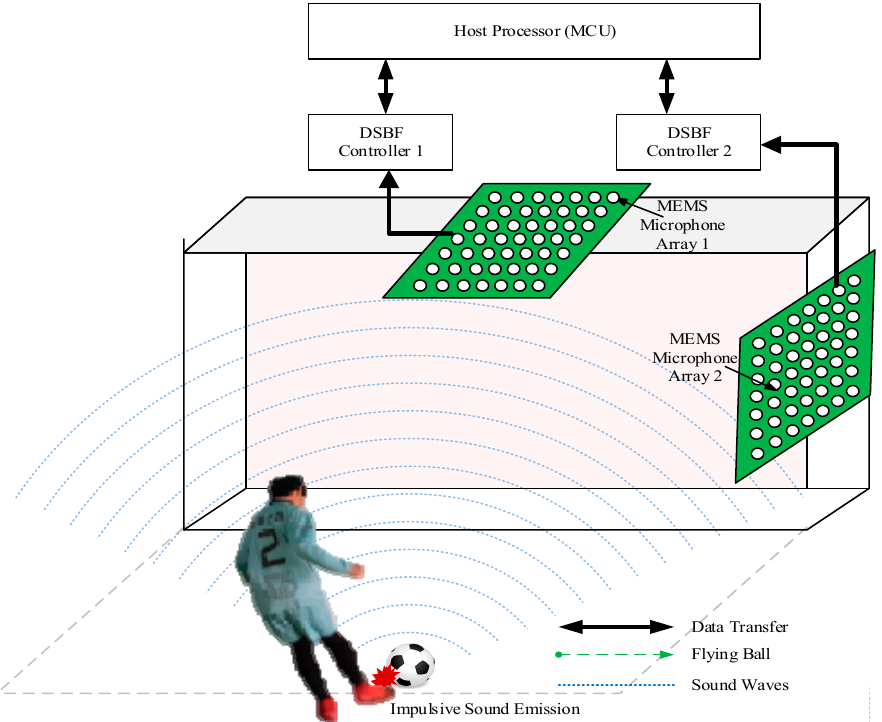
Figure 3. Overview of the proposed system: Acoustic source localization using two delay and sun beamforming (DSBF) systems.